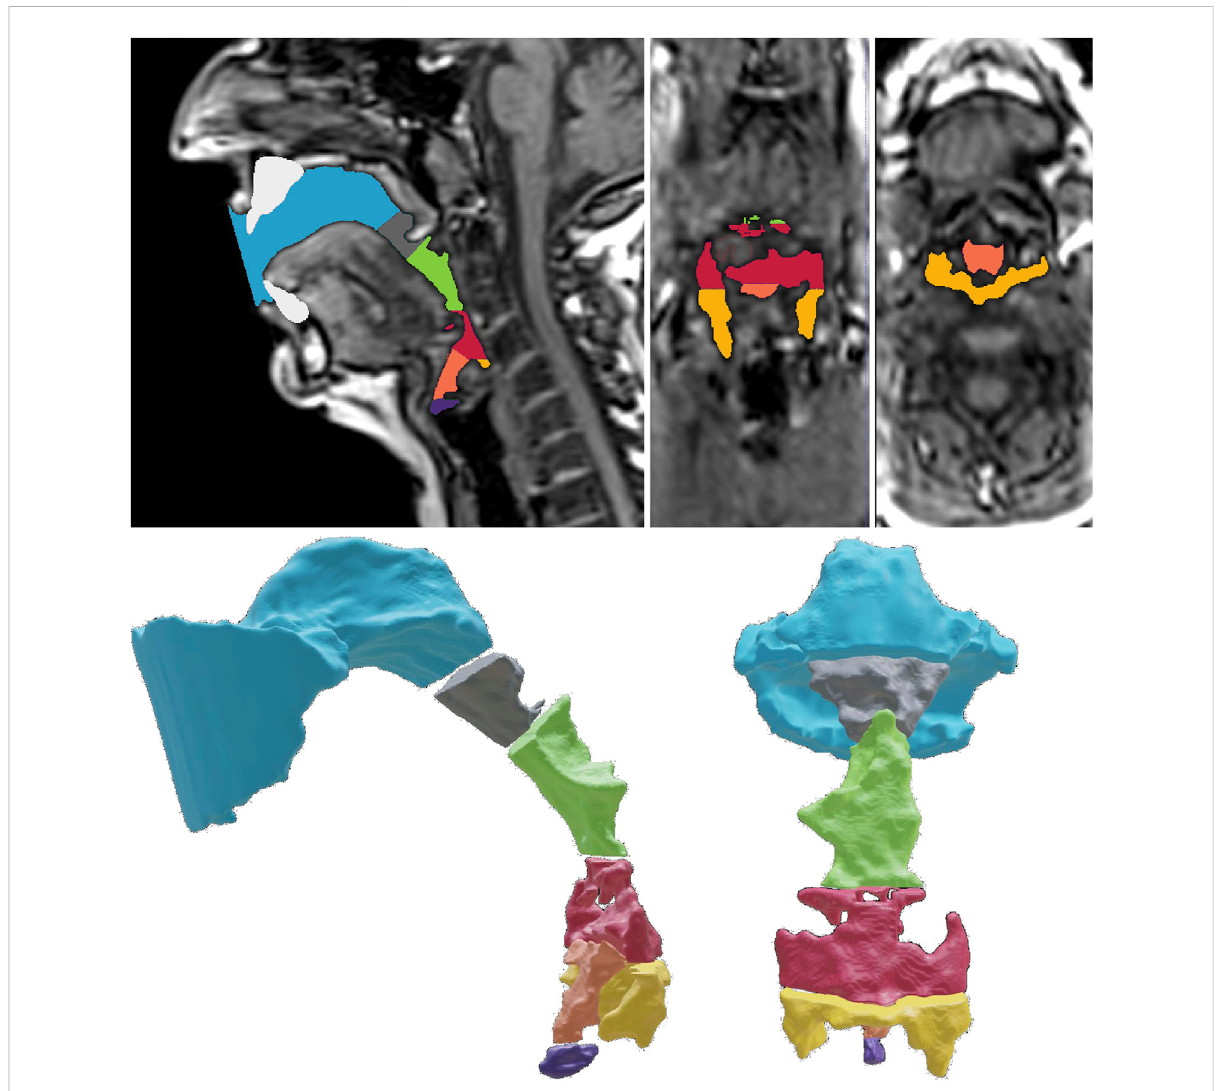
FIGURE 2 De fi nitionofsevensub-volumesneededforthevolumetricanalysisofthesub-volumes(exemplarilyshownforBelting/a ː /(A X 3).Theupperrow showsthemid-sagittal,coronal,andthetransversalplaneoftheMRIdataandthesegmentedcavities.Thelowerrowshowstheexplodedviewofthe sub-volumes in the sagittal and coronal view. The blue color is used to highlight the oropharynx front (OPf), and the oropharynx rear (OPR) is shown in gray. The upper hypopharynx (HPu) is highlighted in green, whereas the lower hypopharynx (HPl) is highlighted in red. Finally, the epilarynx tube (ET), Sinus piriformis (SP), and ventricular volume (VV) are shown in orange, yellow, and purple,